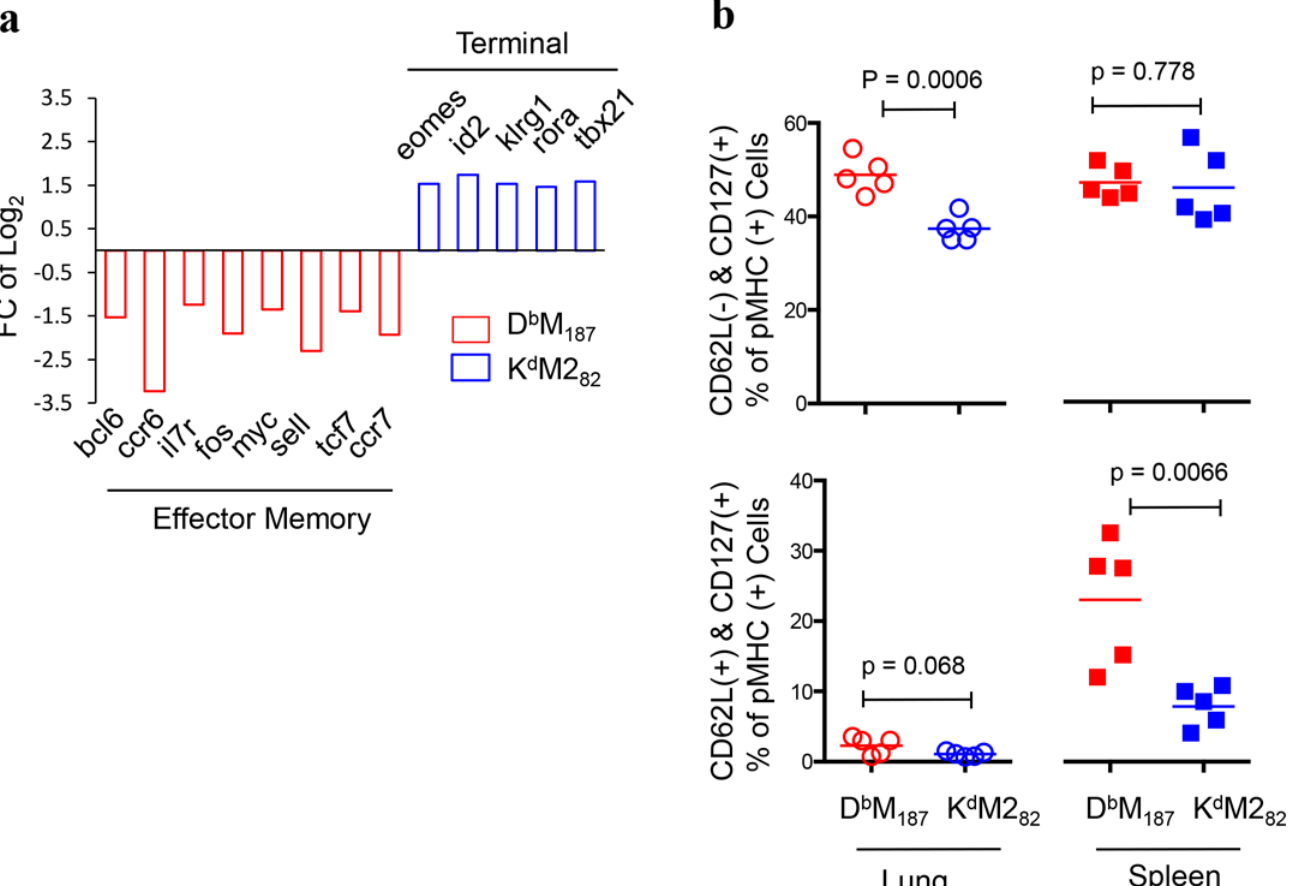
Fig 4. The D b M 187 T cells differentiate toward to an effector- and central- memory phenotype. (a) Transcriptional expressions that are associated with cell differentiation were analyzed and normalized. Relative expression was calculated and presented as Log 2 Fold Change (Log 2 FC). The Log 2 FC = Log 2 K d M2 82 – Log 2 D b M 187 . Positive values indicate a specific gene expression was up-regulated in the K d M2 82 subset, while negative values indicate up- regulated gene expression in the D b M 187 subset. Genes with expression differences of FC > 1.3, p < 0.05 and FDR < 0.25 are listed. Data were pooled from 10 or 11 individual mice in each group. ( b ) Post-transcriptional expression of CD62L and CD127. The CD62L(-)CD127(+) and CD62L(+)CD127(+) frequencies at 7 dpi were assessed by flow cytometry and are shown as mean with independent data point and compared by Student ’ s t -test. Data represent 5 independent experiments (n = 5/group/experiment). Each symbol represents one